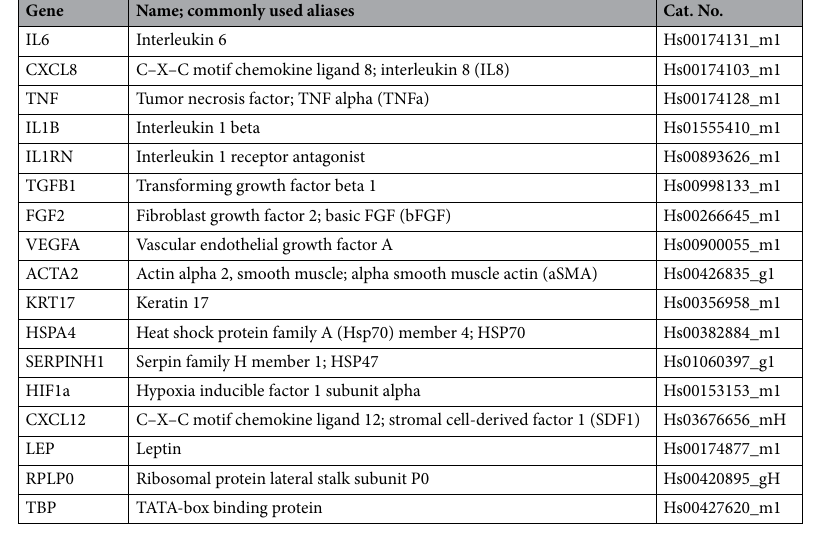
Table 1. Taqman gene expression assays (Thermo Fisher Scientific, MA,